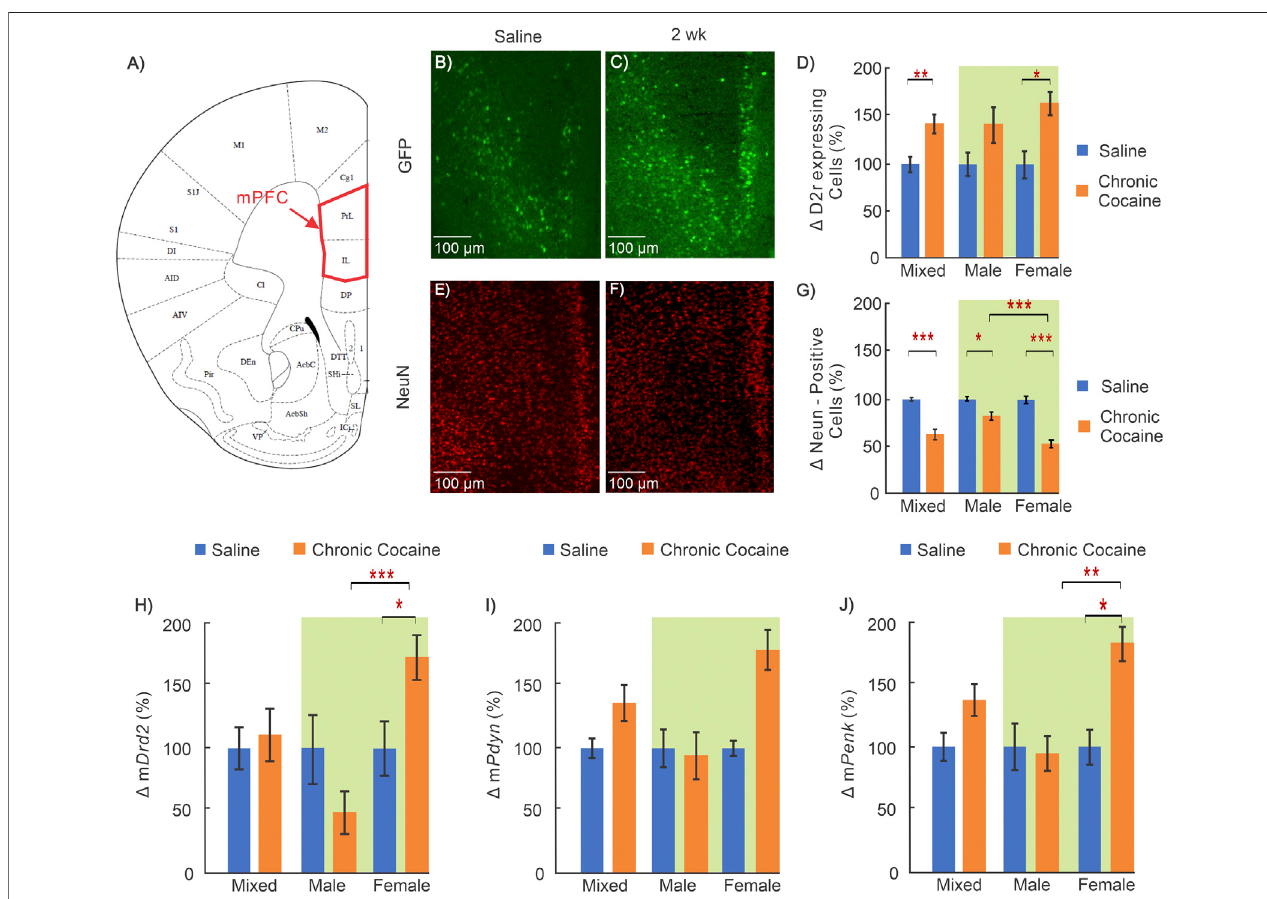
FIGURE 2 | Cocaine effects inmedialprefrontalcortex (mPFC). (A) : Mousebrain atlas showing the locationofthe microscopic imagesinmPFC (Georgeand Franklin, 2001); (B – C) : “ Zoom-in ” GFP in mPFC of a saline and cocaine treated animal; (D) : Comparison of D2r-GFP expressing neurons in mPFC in saline (n (cid:2) 14; 5 \ , 9 _ ) and cocaine(n (cid:2) 13;6 \ ,7 _ )treatedanimals. (E – F) :CorrespondingNeuNimagesinmPFCofasalinetreatedandcocainetreatedmouse; (G) :ComparisonofneuronsinmPFC betweensaline(n (cid:2) 10;5 \ ,5 _ )andcocainetreatedanimals(n (cid:2) 10;6 \ ,4 _ ); (H – J) :ComparisonofmRNAlevelsbetweensaline(n (cid:2) 12;6 \ ,6 _ )andcocaine(n (cid:2) 14; 7 \ ,7 _ )treatedWTmicefor Drd2 (H) , Pdyn (I) ,and Penk (J) .Mixed:malesandfemales;female:femalesonly;male:malesonly;*: p < 0.05;**: p < 0.005;***: p < 0.001.Blue bars correspond to saline and orange ones to cocaine treated mice. Green background indicates data included in two-way ANOVA. Values show averages and